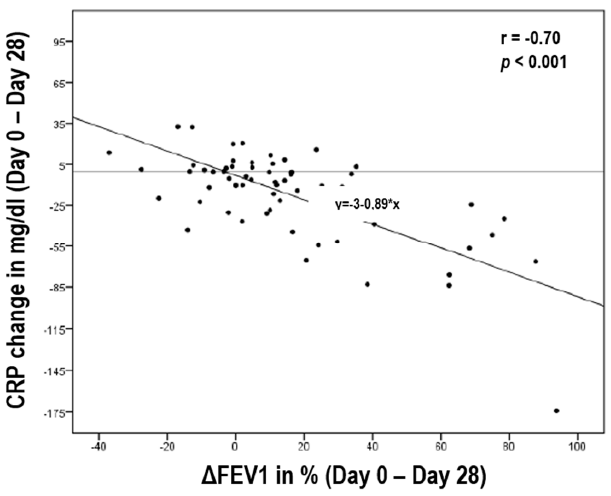
Figure 7. Correlation analysis of Δ FEV1/CRP change (days 0–28), y = regression line.